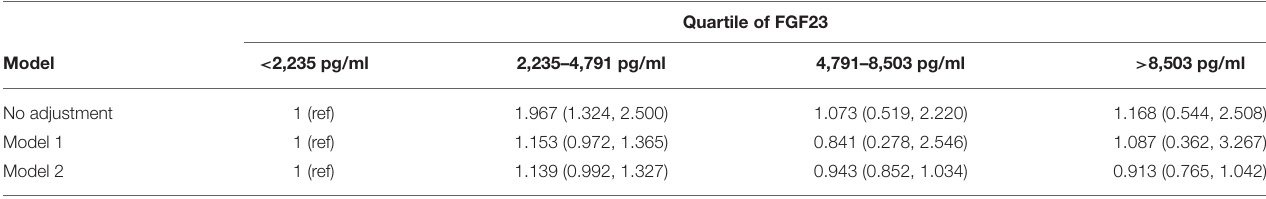
TABLE 7 | Adjusted HR (95% CI) for mortality by quartile of